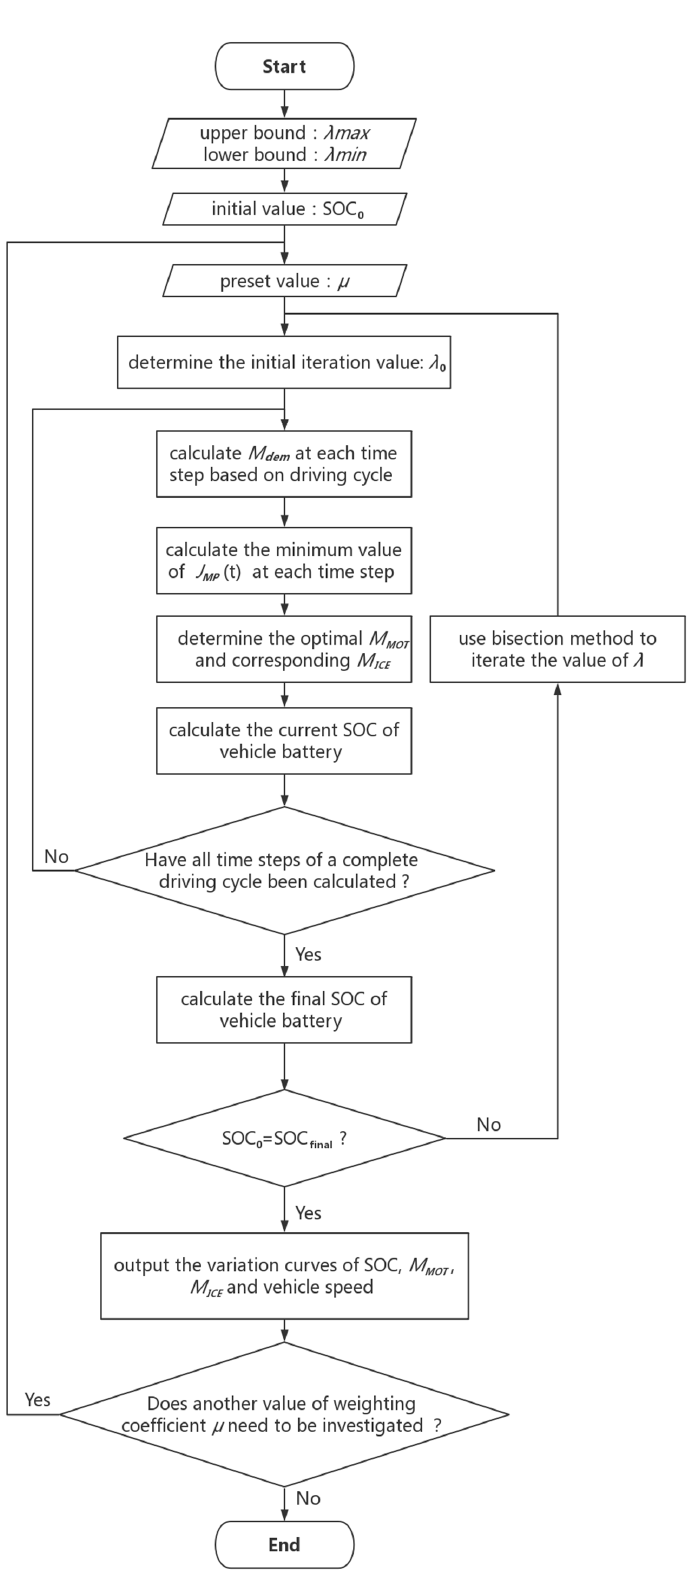
Figure 8. Unified modeling language (UML) activity diagram for the control algorithm.